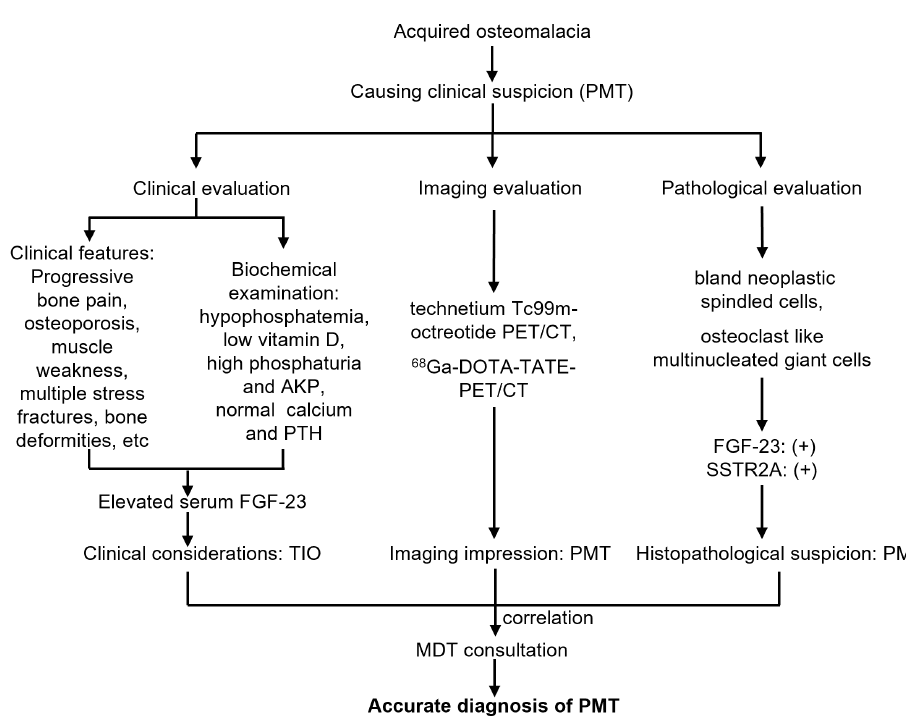
Figure 6. Flow chart of accurate diagnosis of phosphaturic mesenchymal tumors.